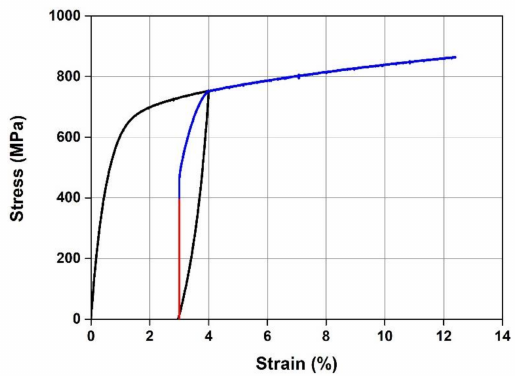
Figure 2. Stress-strain curve of Fe-SMA with recovery stress